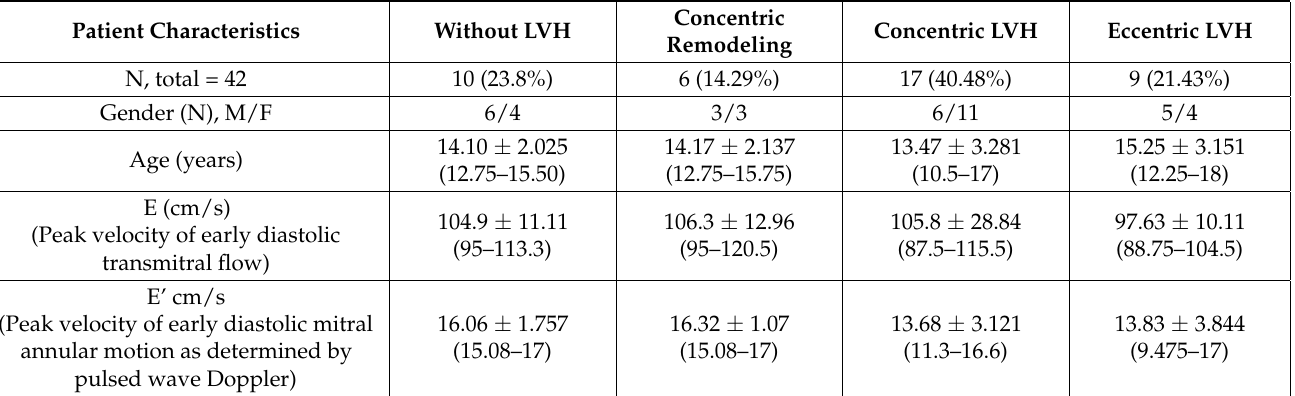
Table 2. Patient’s characteristics and echocardiographic measurements (mean ± SD and 95% confi- dence